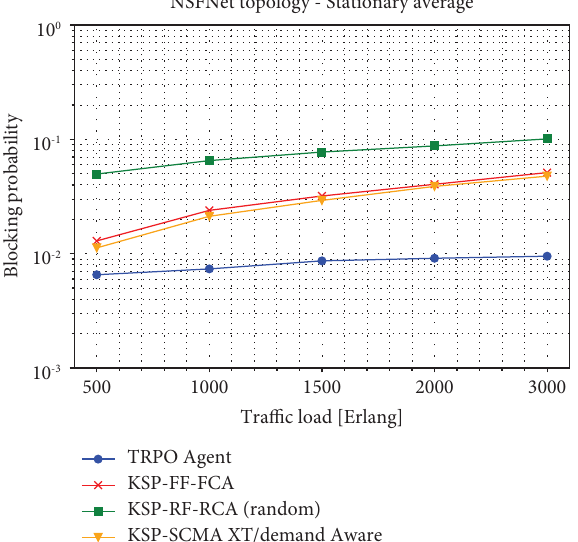
Figure 9: Blocking probability steady average of TRPO agent trained in NSFNet topology.